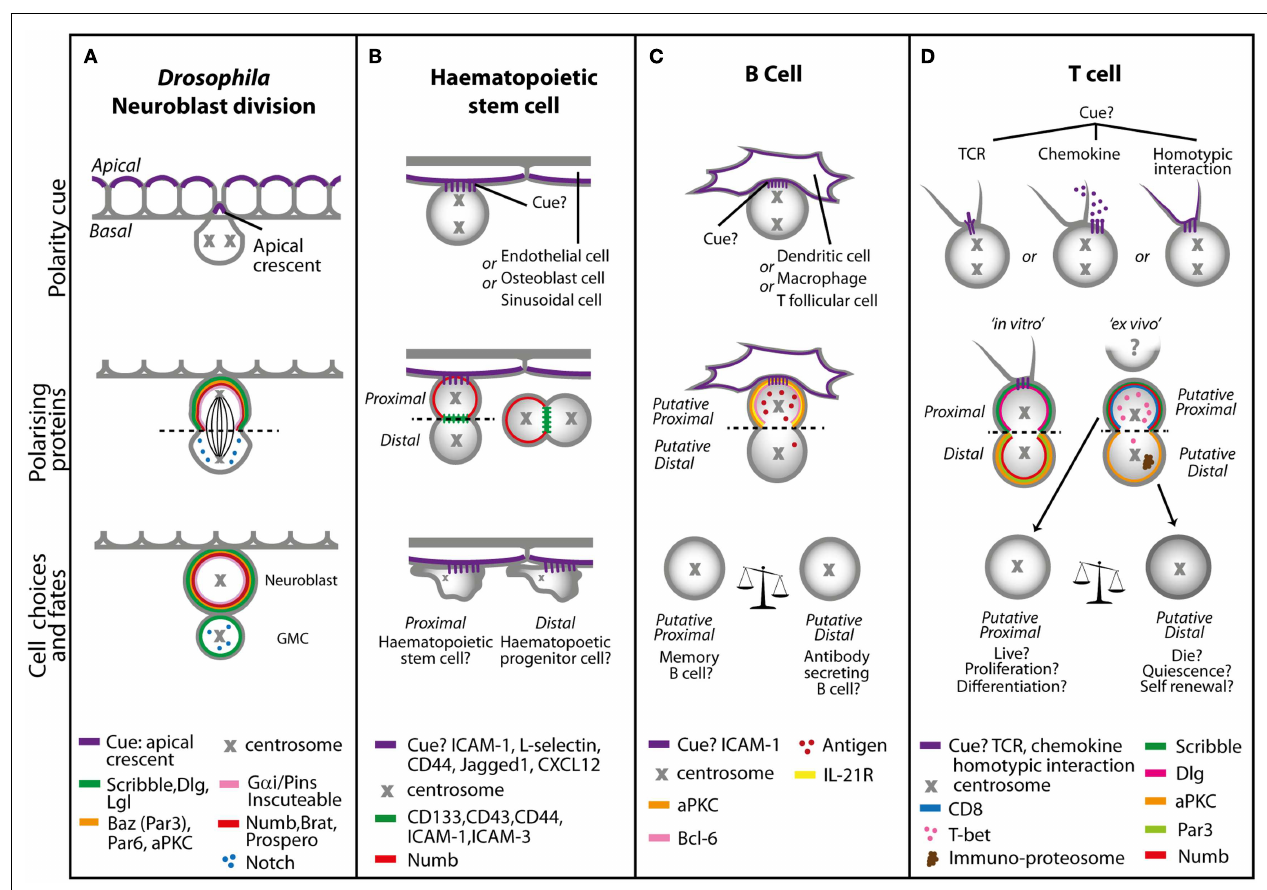
FIGURE 3 | Models of asymmetric cell division in (A) Drosophila neuroblasts, (B) hematopoietic stem cells, (C) B cells, and (D)T cells . (A) In Drosophila , neuronal precursors delaminate from the neurepithelium to undergo ACD.The polarity cue is the apical crescent, and during early division duplicated centrosomes rotate 90° to create the distinct apical and basal sides that are mediated by the Scribble and Bazooka polarity protein complexes. During late division, the coordination of the spindle length by G α i signaling and proteins such as Inscuteable and Pins result in asymmetric distribution of cell fate determinants, such as Numb, Notch, Brat, and Prospero.The coordination and maintenance of signaling results in a self-renewing neuroblast cell and a ganglion mother cell (GMC). In cells of the hematopoietic system, multiple polarity cues can dictate asymmetric cell division. (B) Hematopoietic stem cells migrating in a stem cell niche in the bone marrow can receive adhesion, Notch or chemokine cues from surrounding endothelial, osteoblast, or sinusoidal cells, resulting